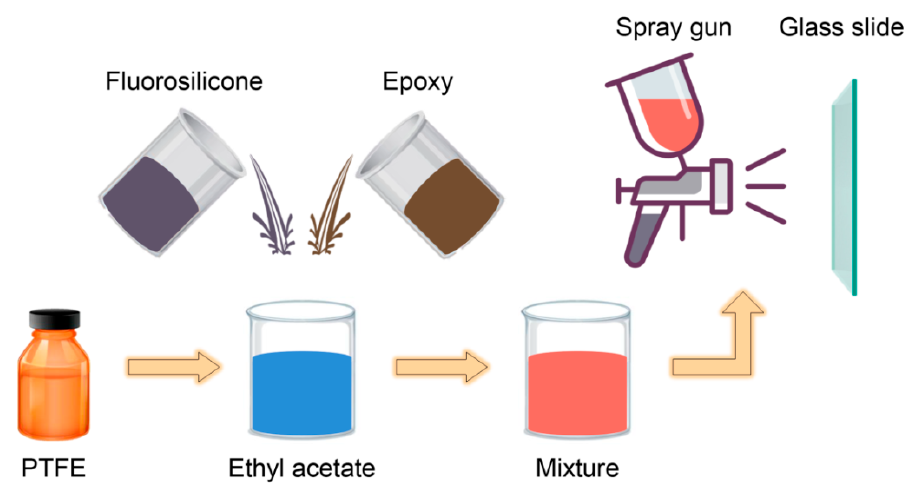
Figure 1. Preparation of superhydrophobic coating by one-step spraying.